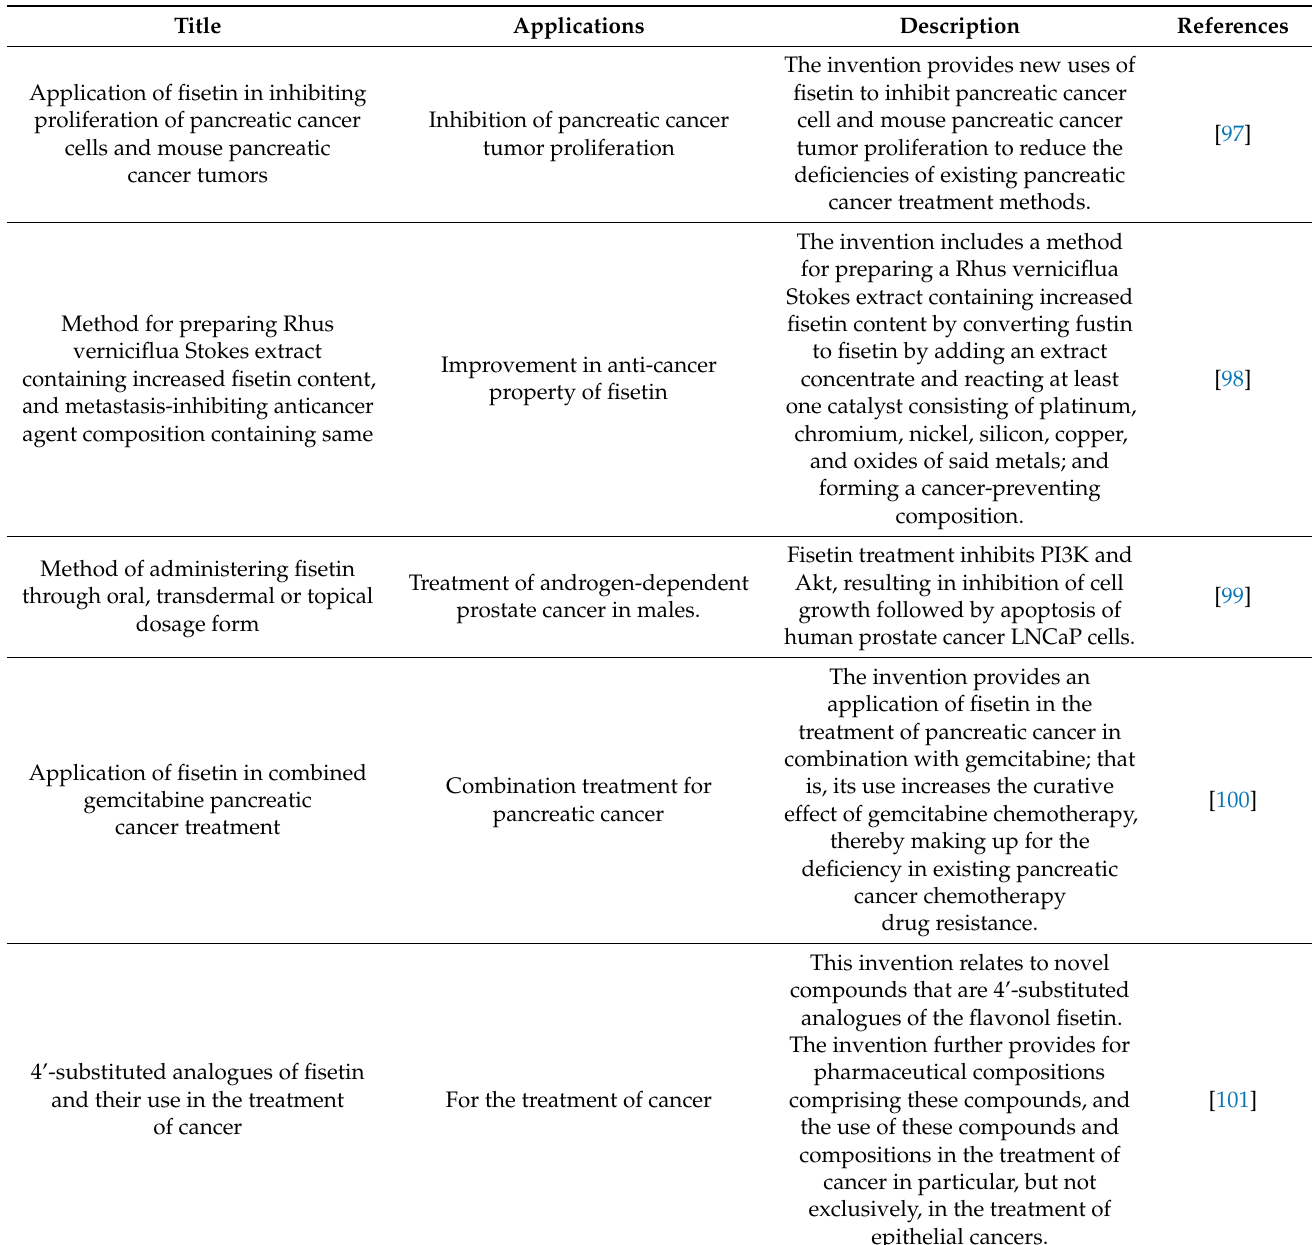
Table 3. List of patents filed on fisetin